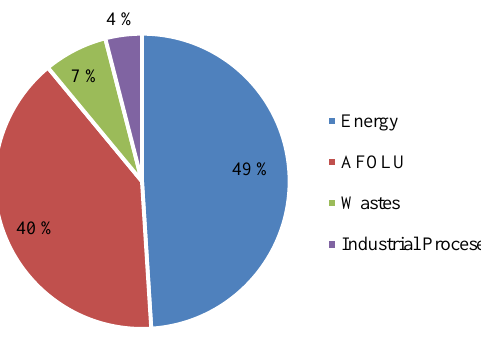
Fig. 2. GHG emissions distribution by sector in 2013